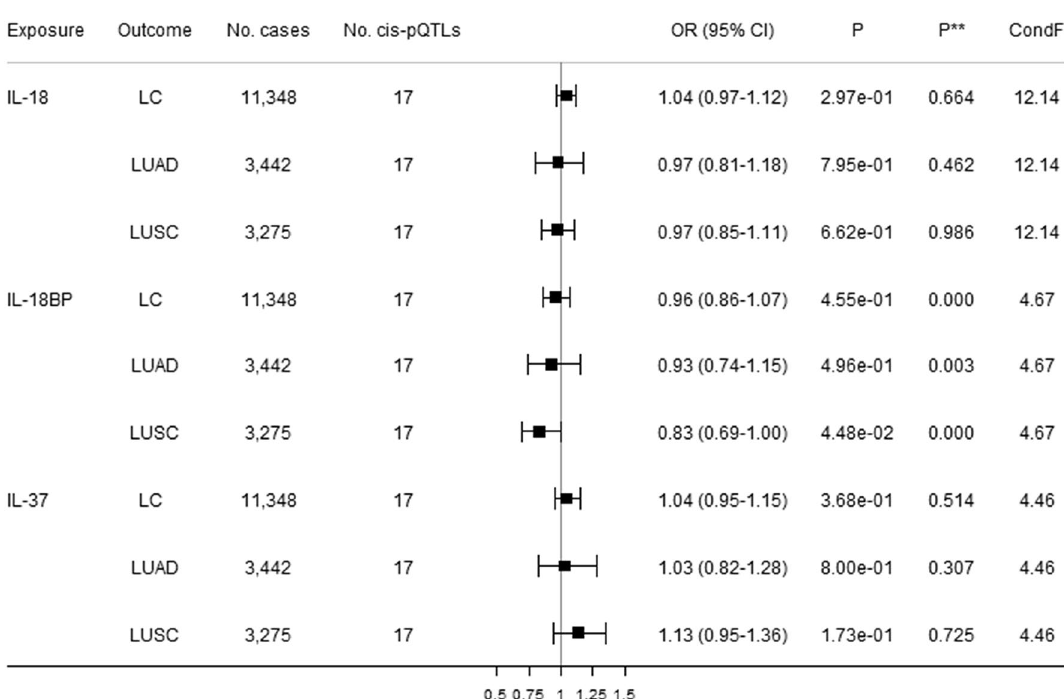
Figure 3. Direct causal estimates of genetically predicted IL-1α, IL-1β, and IL-1Ra with lung cancer (LC) and its subtypes [lung adenocarcinoma (LUAD) and squamous cell lung cancer (LUSC)] using robust multivariable MR analyses. Cis -pQTLs is cis protein quantitative loci. P ** indicates a pleiotropy test based on the MVMR Egger. ConF indicates the overall conditional F-statistic. The modified Q-statistic for LC, LUAD, and LUSC are respectively 8.27 ( P = 0.607), 6.32 ( P = 0.788), and 9.27 ( P = 0.507).